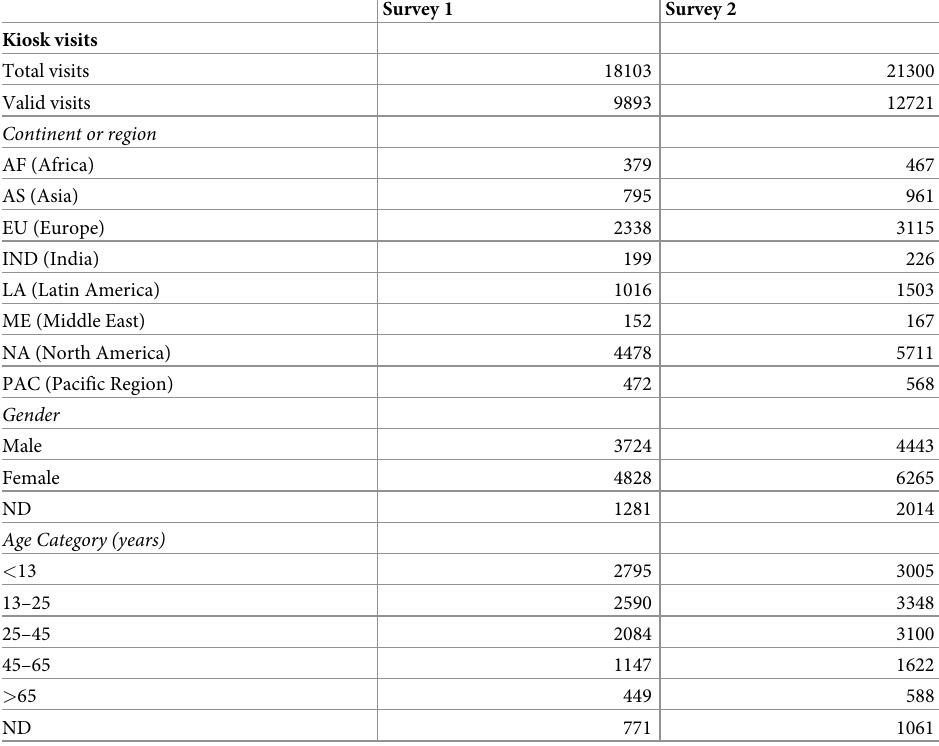
Table 3. Demographics of the kiosk